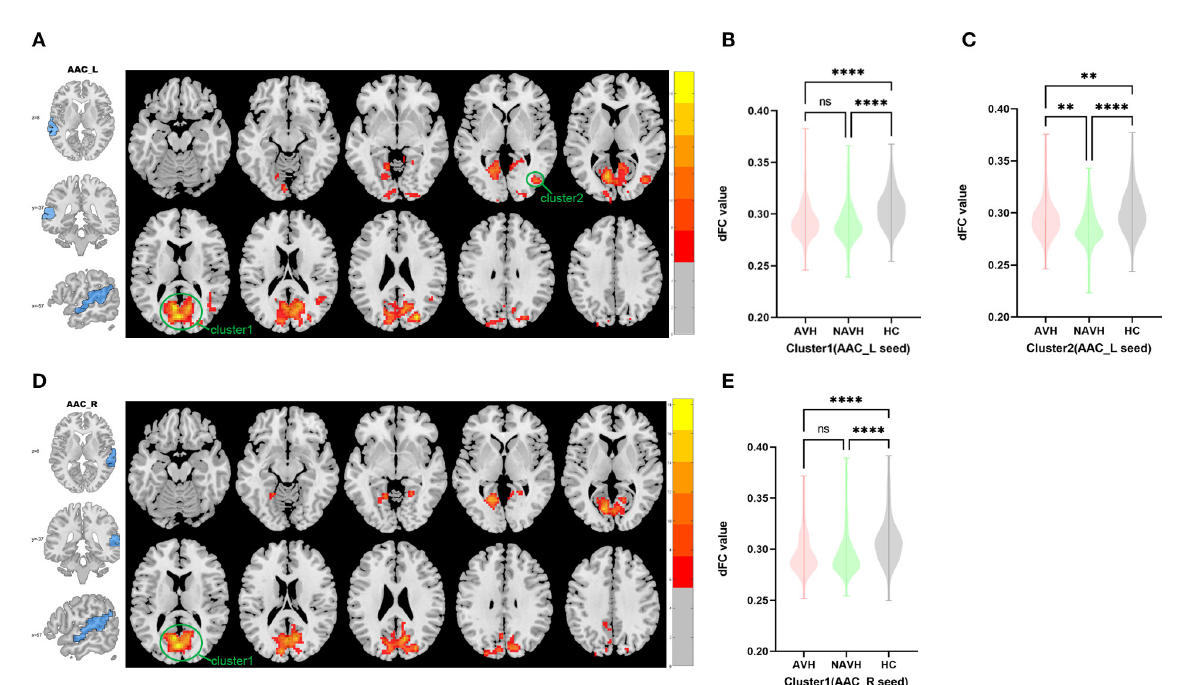
FIGURE1 Brain regions showing abnormal dFC values among AVH, NAVH and HC groups in MNI space using left and right AAC as seeds. (A) Significant dFC value differences were observed in cluster1 (bilateral calcarine gyrus, bilateral cuneus gyrus, bilateral lingual gyrus, bilateral superior occipital gyrus, bilateral precuneus gyrus, posterior cingulate gyrus) and cluster2 (right middle temporal gyrus and right middle occipital gyrus) using left AAC as seed. (B,C) Altered dFC values in cluster1 and cluster2 among AVH, NAVH and HC groups using left AAC as seed. (D) Significant dFC value differences were observed in cluster1 (bilateral calcarine gyrus, posterior cingulate gyrus, bilateral cuneus gyrus, bilateral lingual gyrus, bilateral superior occipital gyrus, bilateral precuneus gyrus) using right AAC as seed. (E) Altered dFC values in cluster1 among AVH, NAVH and HC groups using right AAC as seed. **** Significant at 0.0001 level, *** significant at 0.001 level, ** significant at 0.01 level and * significant at 0.05 level